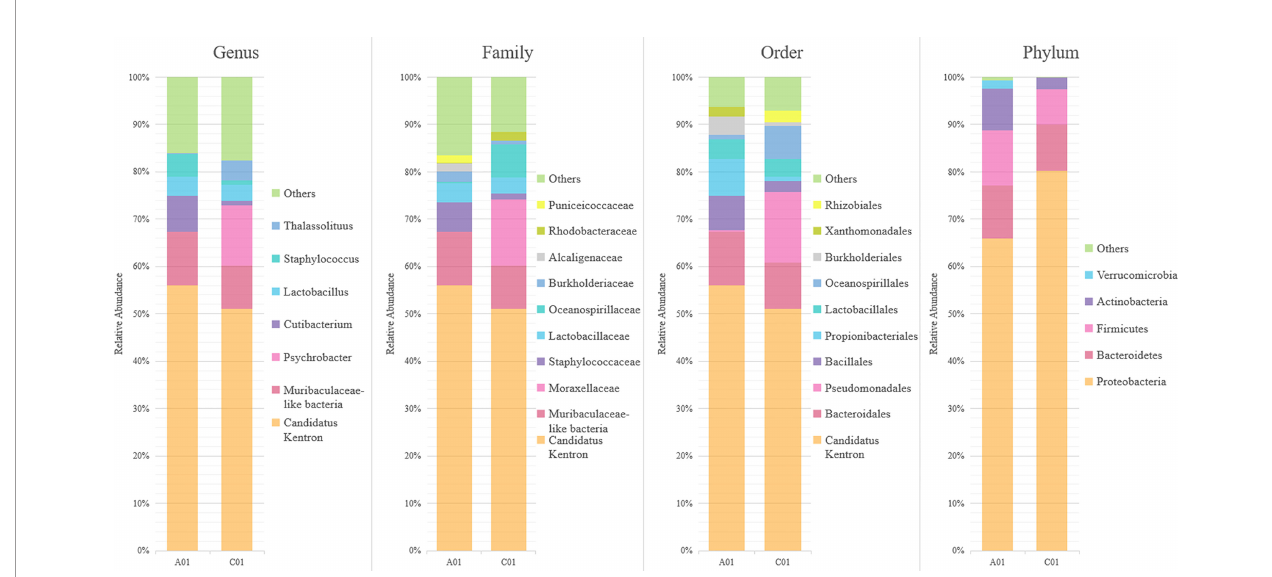
FIGURE 4 | Relative abundances of the bacterial major taxa in Kentrophoros fl avus YE, inferred by the PacBio data. Note that the genera, “ Candidatus Kentron ” and Muribaculaceae -like bacteria, are shown as the most frequently occurring taxa. A01 and C01 represent different individuals of Kentrophoros fl avus YE.